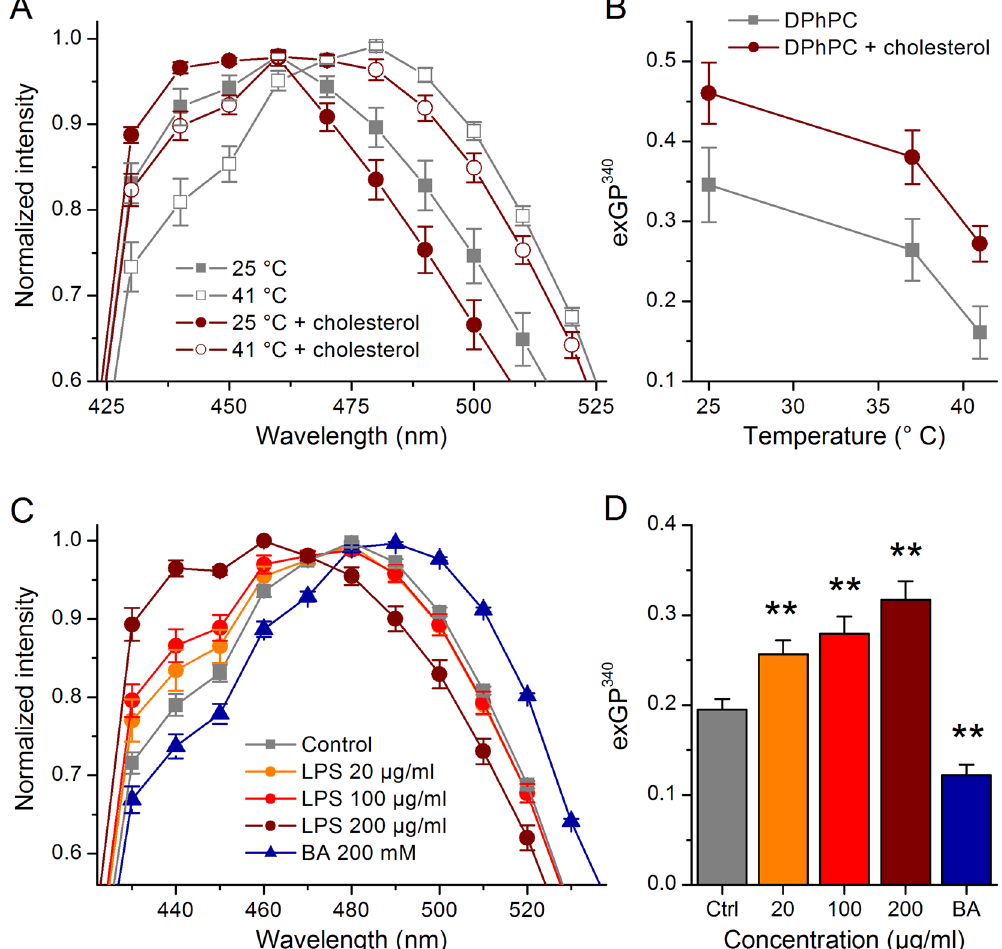
Figure 4. Effects of E . coli LPS on Laurdan’s emission spectrum in DPhPC GUVs. ( A ) Laurdan’s emission spectra obtained at 25 °C and 41 °C in control DPhPC GUVs and in DPhPC GUVs containing 20% cholesterol. ( B ) Laurdan exGP 340 as function of temperature determined in DPhPC GUVs or DPhPC GUVs containing 20% cholesterol. ( C ) Effect of E . coli LPS (20, 100 and 200 µ g/ml) or 200 mM BA on Laurdan’s emission spectrum recorded at 37 °C in DPhPC GUVs. ( D ) Laurdan exGP 340 determined in control, in the presence of E . coli LPS (20, 100 and 200 µ g/ml) or BA (200 mM). Data from at least three samples performed in at least triplicate. ** P < 0.01; Mann-Whitney U